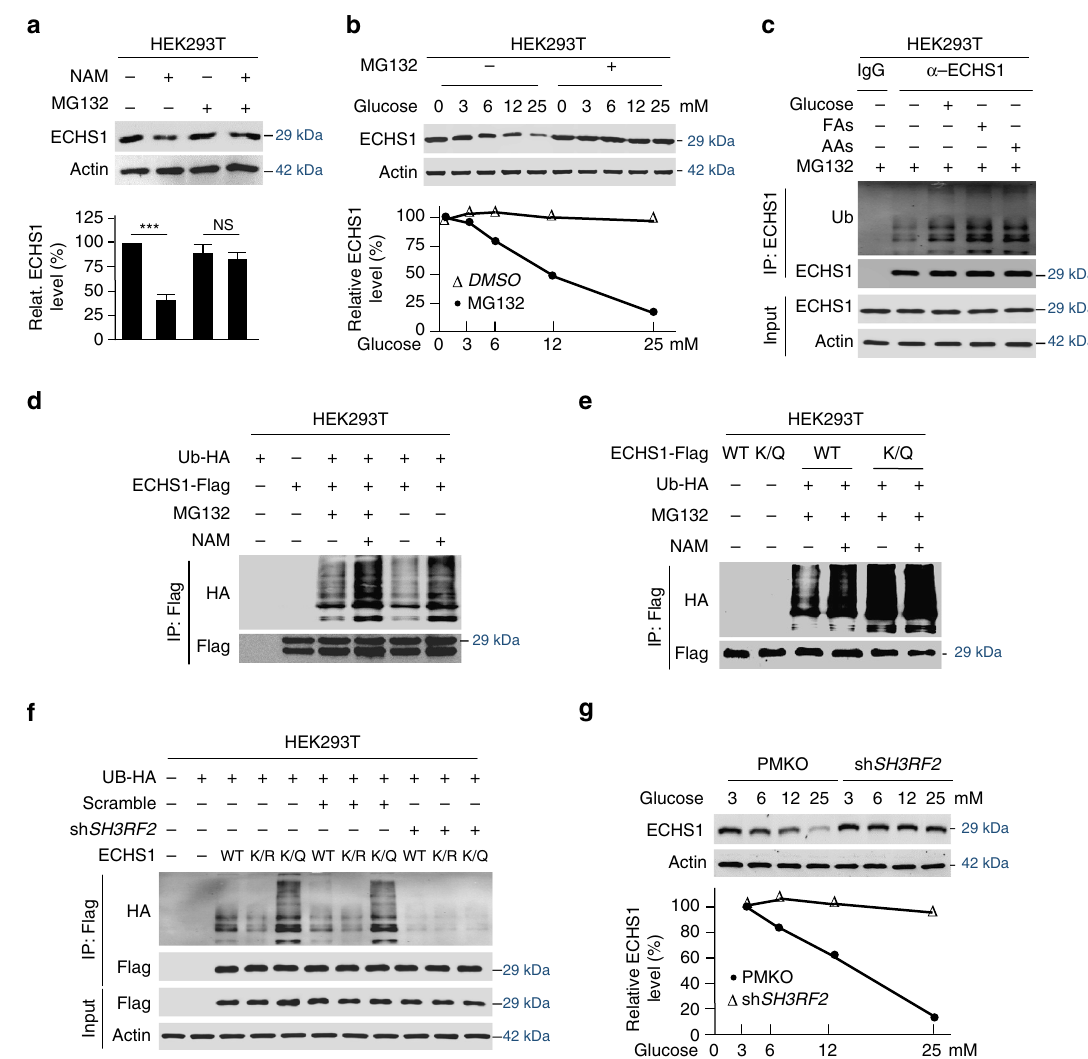
Fig. 5 K101 acetylation promotes ECHS1 ubiquitination and degradation. a NAM treatment effects on endogenous ECHS1 levels in HEK293T cells were analyzed in the presence and absence of MG132. Mean values of quantitation with SD are reported. NS not signi fi cant; *** P < 0.001. b The endogenous ECHS1 levels in HEK293T cells that were cultured under various glucose levels were detected under absence (DMSO) and presence treatments with MG132. c The ubiquitination of af fi nity-puri fi ed endogenous ECHS1 from HEK293T cells that were cultured with DMEM base and DMEM base supplemented with glucose, fatty acids, and amino acids, respectively, were determined. d Flag-tagged ECHS1 was expressed in HEK293T cells. The ubiquitination levels of ECHS1 expressed from cells cultured with either NAM or MG132, or both NAM and MG132 treatments were analyzed. e Flag- tagged ECHS1 or K/Q mutant were expressed alone or with HA-tagged ubiquitin in HEK293T cells cultured with or without NAM. The ubiquitination levels of Flag bead af fi nity-puri fi ed ECHS1 were analyzed. f The ubiquitination levels of ectopically expressed Flag-tagged ECHS1, K/R and K/Q mutants from HEK293T and shSH3RF2 knockdown (KD effects please see Supplementary Fig. 7d) HEK293T cells. g Endogenous ECHS1 levels were detected